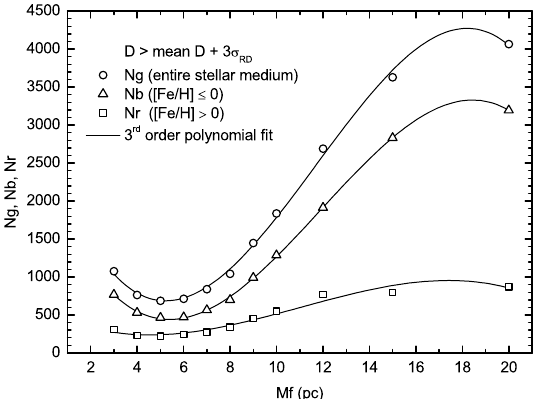
Fig. 9. Variation of the number of fractal dimension values D beyond three standard deviations as a function of scale factor Mf in the entire stellar medium ( Ng ), and among stars with [Fe = H] (cid:20) 0 ( Nb ) and [Fe = H] > 0 ( Nr